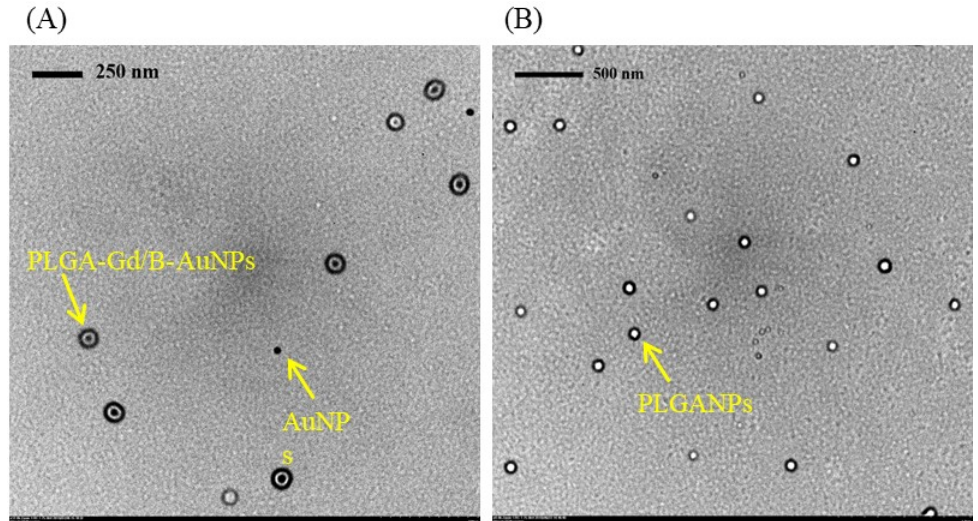
Figure 1. The TEM images of ( A ) PLGA-Gd/B-AuNPs and ( B ) PLGA NPs. 2.2. Assessment of In Vitro Cellular Uptake Table 1. The formulation and physical properties of various nanoparticles. Cellular uptakes of PLGA-BC/Gd-AuNPs and thiol B cage were determined by the percentage of B atoms retained in cells (%AD/10 7 cells). The accumulation of PLGA- BC/Gd-AuNPs in N87 cells increased with time, reaching a maximum of 0.68 ± 0.24 at 36-h post-incubation (Figure 2). However, the retention of thiol B cage was lower than that of PLGA-BC/Gd-AuNPs at almost all time points except for the initial 4 h (0.22 ± 0.24 for thiol B cage vs. 0.09 ± 0.03 for PLGA-BC/Gd-AuNPs), suggesting that PLGA encapsulation can improve the B content in N87 tumor cells.